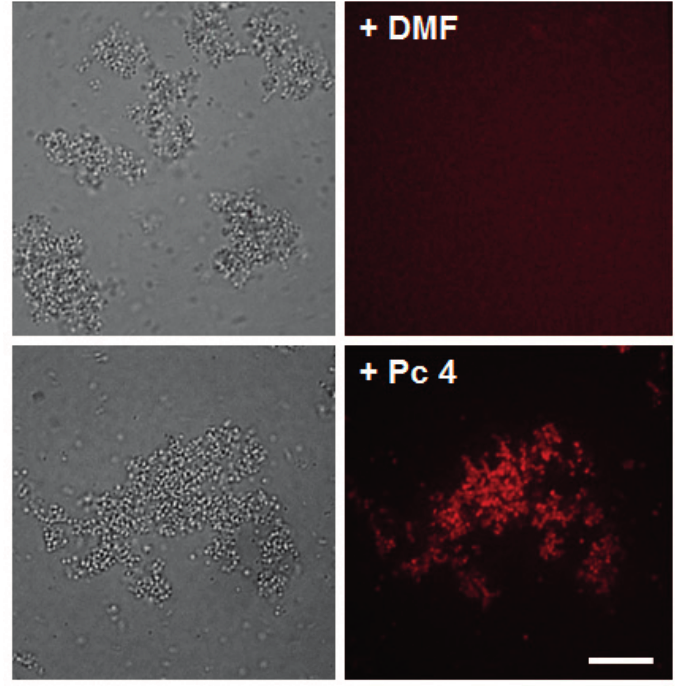
Figure 1. Phthalocyanine (Pc) 4 uptake in S. aureus . Bacteria were loaded with either 1.0 μ M Pc 4 ( top panels) or (vehicle control) N ', N '-dimethylformamide (DMF) ( bottom panels) overnight. Pc 4 ( pseudo red ) fluorescence appears to be taken up efficiently in HA-MRSA and equally comparing to the other two strains, MSSA and CA-MRSA (data not shown), within 3 h of incubation . Scale bars, 200 μ m